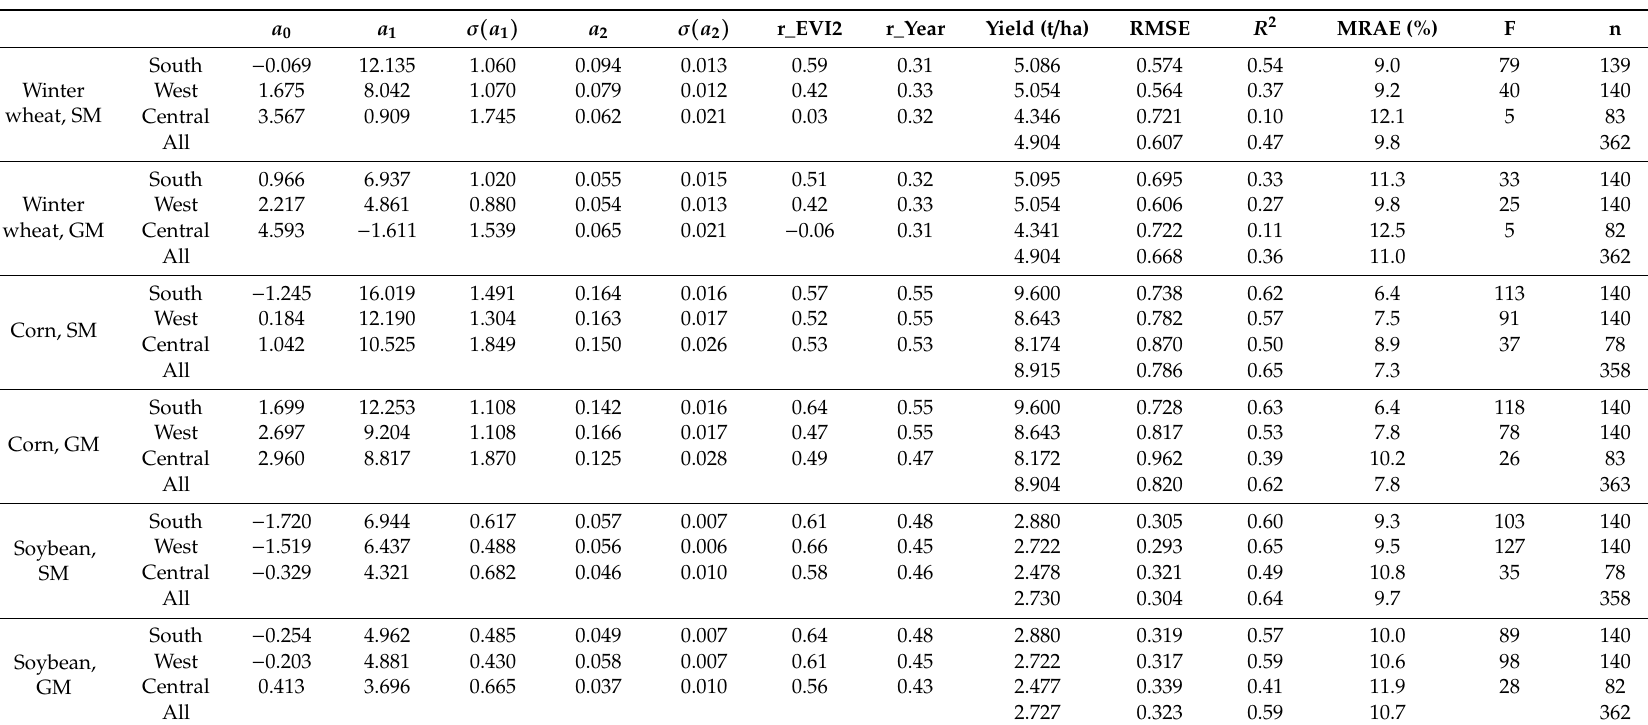
Table 1. Models for yield estimation (Equation (2)) in three agricultural regions, and their performance assessment. a 0 , a 1 , and a 2 : coe ffi cients of the multiple linear regression model; σ : the uncertainty of the coe ffi cient; r_EVI2 and r_Year: correlation coe ffi cients for EVI2 and year, respectively; mean yield: average county level yields; RMSE: root mean square error of estimation; R 2 : coe ffi cient of determination; MRAE: mean relative absolute error of estimation; F : F -test; n : number of samples; SM: crop-specific mask; GM: general cropland mask. All models are at the significance level of p < 0.001, except for shaded models with p <